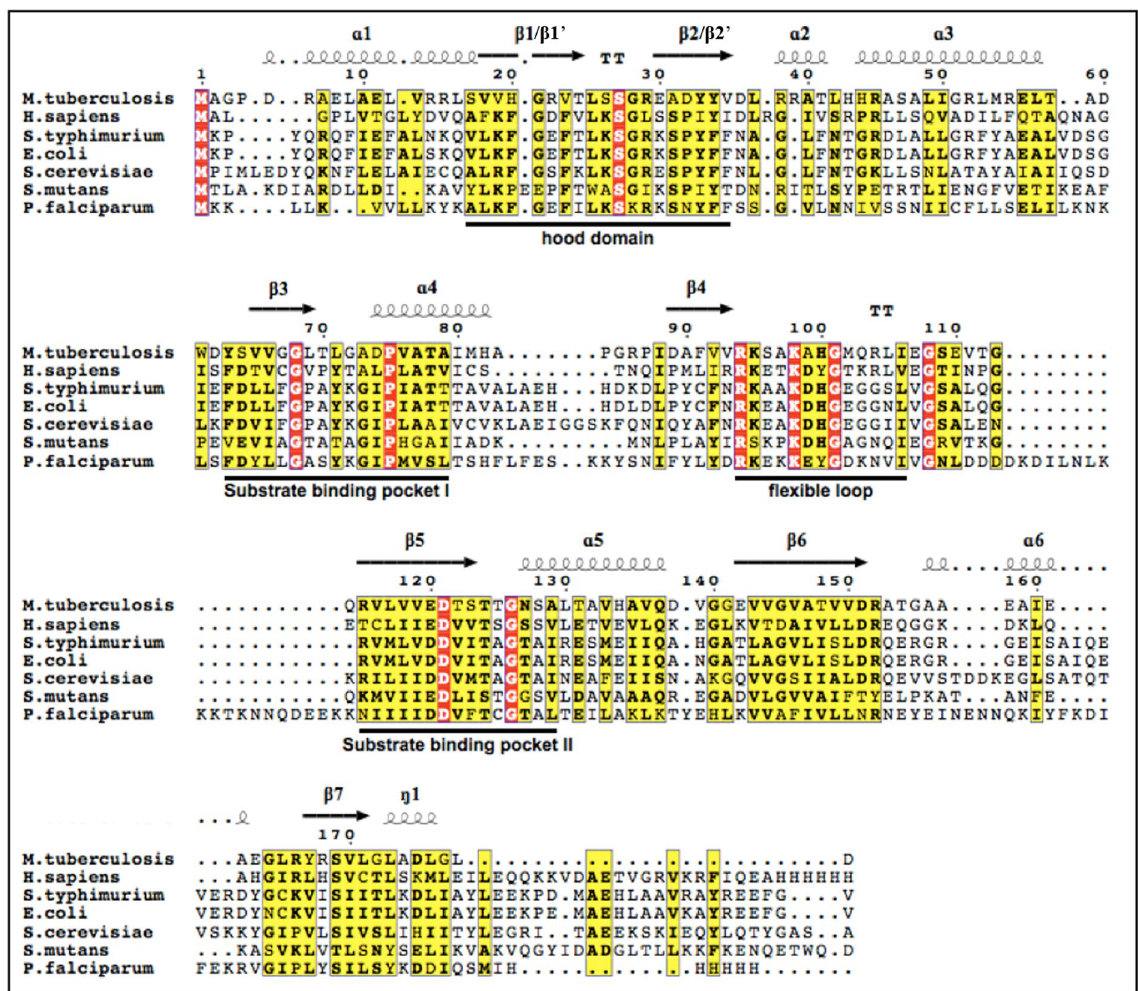
Figure 2. Sequence alignment of various OPRTase. Aligned sequences of OPRTase from M. tuberculosis H37Rv, H. sapiens , S. typhimurium , E. coli , S. cerevisiae , S. mutans and P. falciparum . Conserved residues are shown on a red background, whereas chemically similar residues are displayed on a yellow background. Numbering and secondary structure elements assignments, together with the position of hood domain, substrate binding pockets I–II, and the flexible loop, are highlighted for the mycobacterial